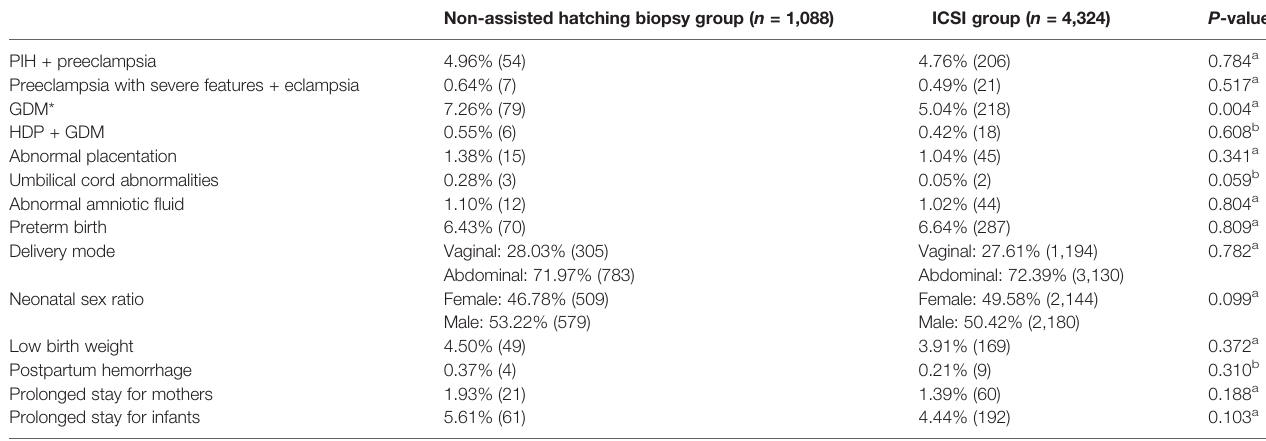
TABLE 2 | Comparisons of maternal and neonatal outcomes between the non-assisted hatching biopsy group and the ICSI